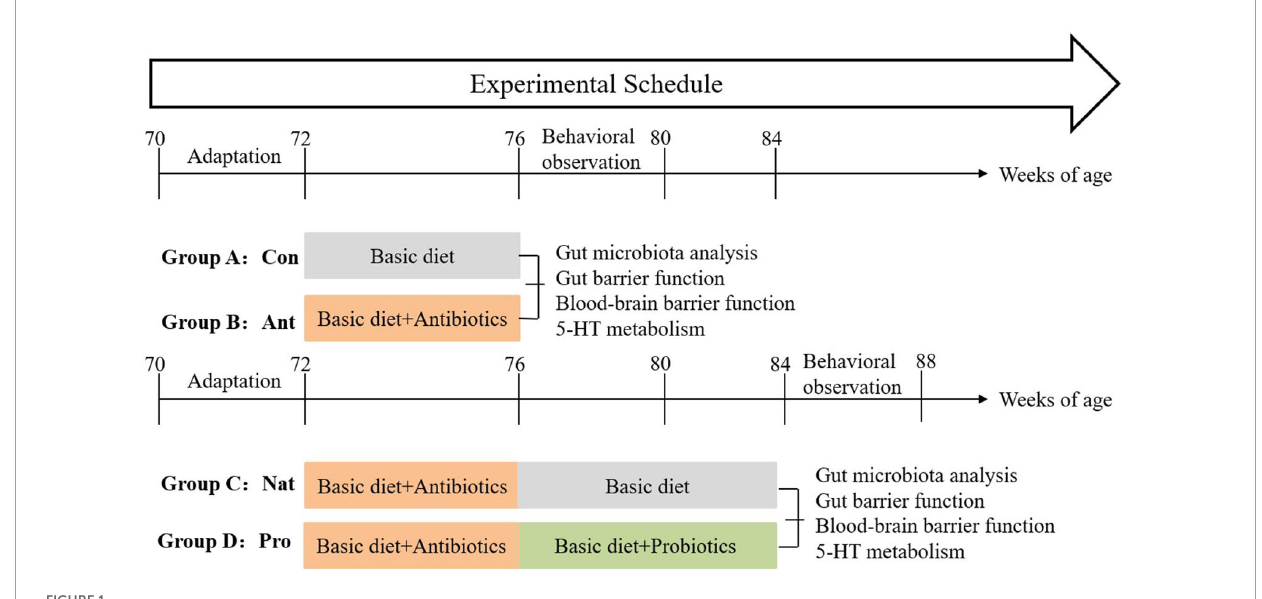
FIGURE1 Schematic diagram showing treatment groups and the experimental timeline.